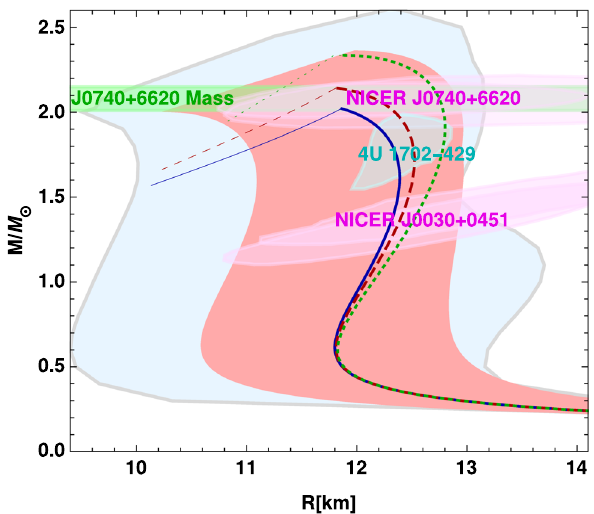
Fig. 17 Mass-radius relations for the hybrid EOSs. Notation is in Fig. 15: the light blue band is determined by all interpolating EOSs satisfying the astrophysical bounds, and the light red band is deter- mined by the hybrid V-QCD EOSs satisfying the same bounds. The blue, dashed red, and dotted green curves are the mass-radius relations for soft, intermediate, and stiff V-QCD(APR) EOSs, respectively. I also show experimental results for neutron star masses and radii, see text for